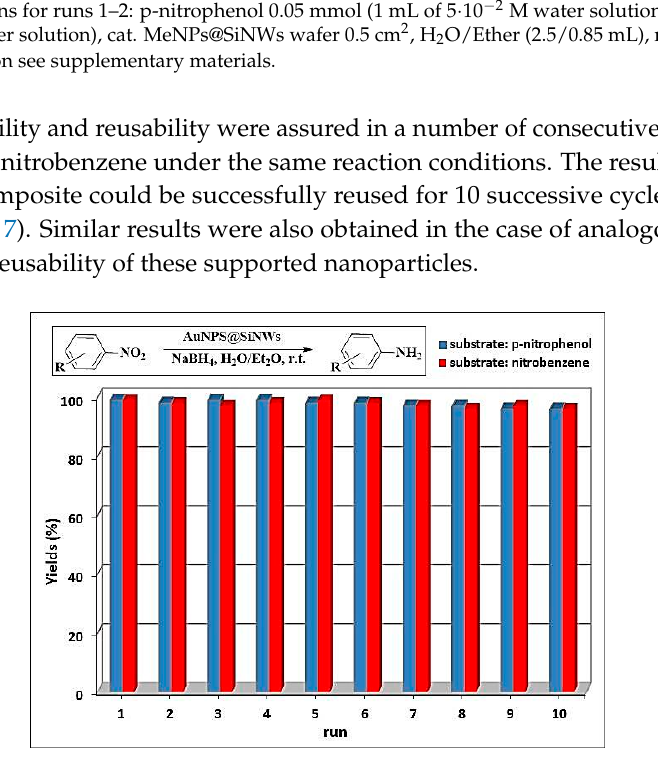
Figure 7. Recycling experiments for AuNPs@SiNWs catalyst in the reduction of nitroarenes with NaBH 4 .